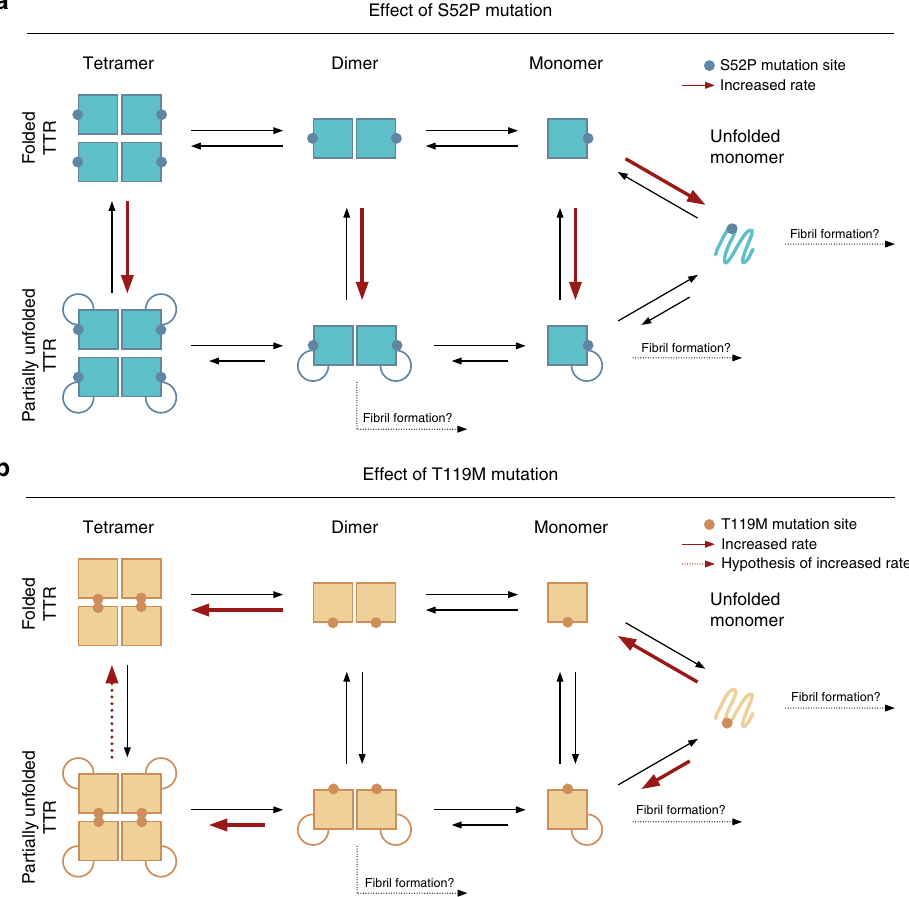
Fig. 4 Proposed model of mutational effect on TTR stability. Shorter arrows indicate a lower propensity to association/folding. Red arrows re fl ect the qualitative change in reaction rates for the mutants with respect to WT-TTR. a The S52P mutation increases the likelihood of partial and full unfolding of TTR monomeric units. This, in turn, also leads to a lower stability of TTR multimeric assemblies; hence partially unfolded dimers and monomers, and fully unfolded monomers, are generated at a higher rate. Some or all of these species are then removed from solution via the formation of amyloid fi brils. b In contrast to S52P, the T119M mutation stabilises the folded monomeric forms of TTR. Most importantly, this mutation has a large stabilising effect on TTR tetramers, which are believed not to form fi brils. Furthermore, it is proposed that the higher stability of the tetramer also has the effect of further stabilising the monomer